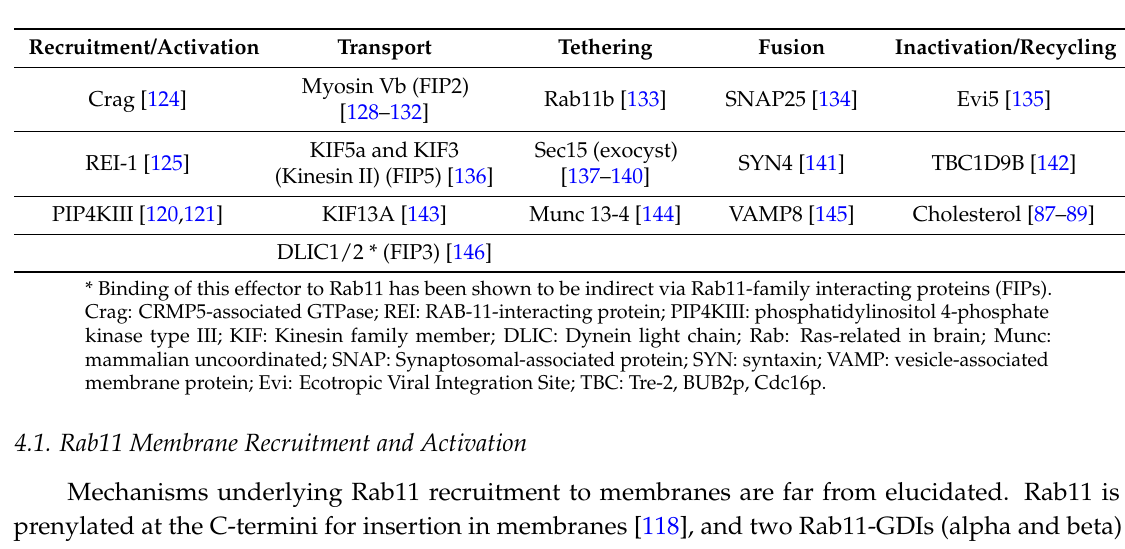
Figure 4. Rab11 cycle in vesicular transport (steps in Rab11 cycle are numbered from 1 to 6). Table 1. Modulators and effectors identified in Rab11 cycle in vesicular transport.